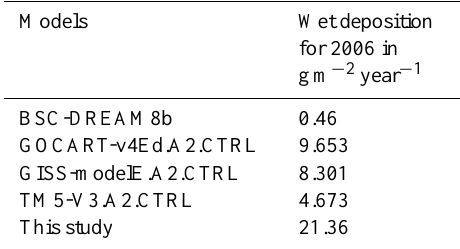
Figure 6. Seasonal mean dry deposition flux simulated by ALADIN (in gm − 2 ) over northern Africa averaged for the 2006–2010 period.